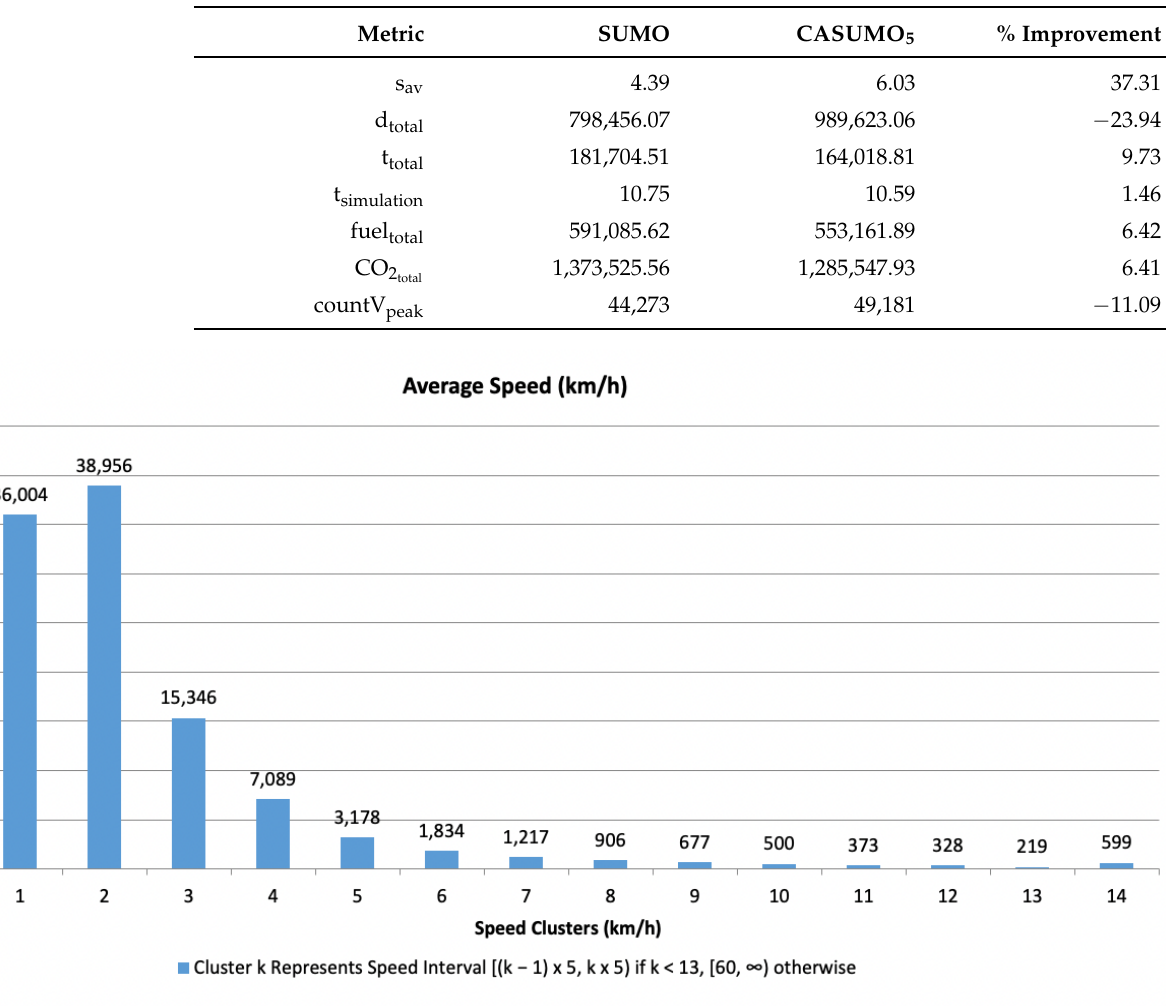
Table 11. Results and improvement of the proposed solution for 100 K+ simulated vehicles in New York.